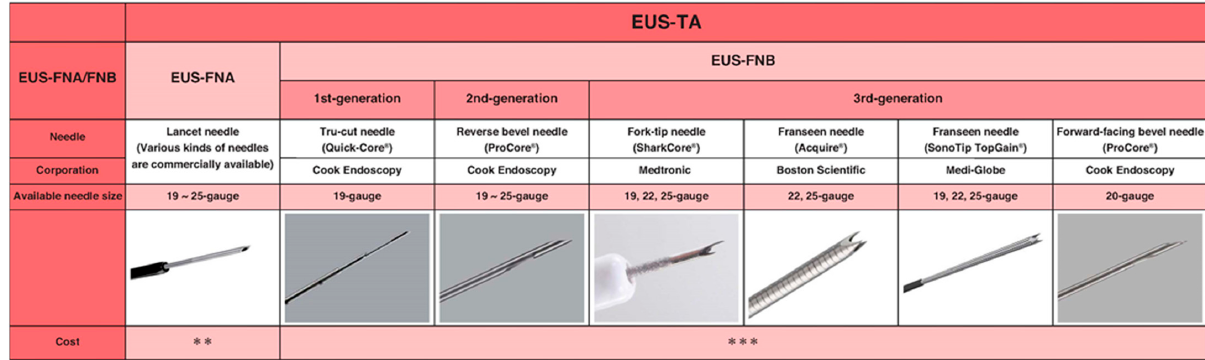
Figure 1. Overview of the needle design of EUS-FNA and -FNB